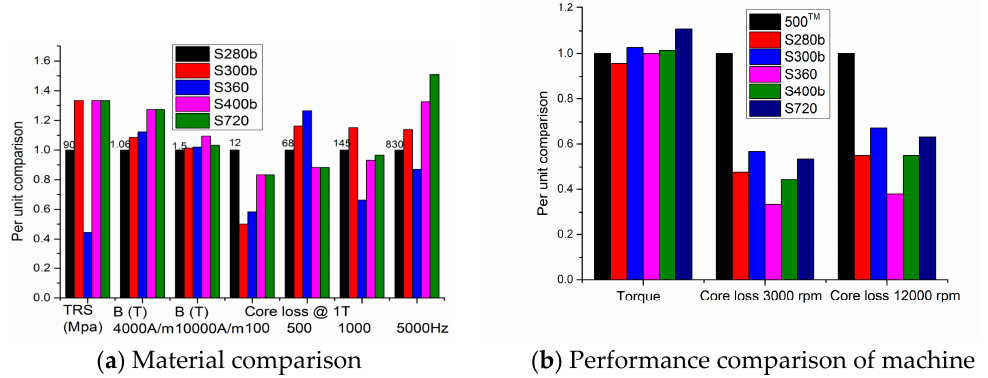
Figure 16. Performance comparison between CPM with different SMC materials.